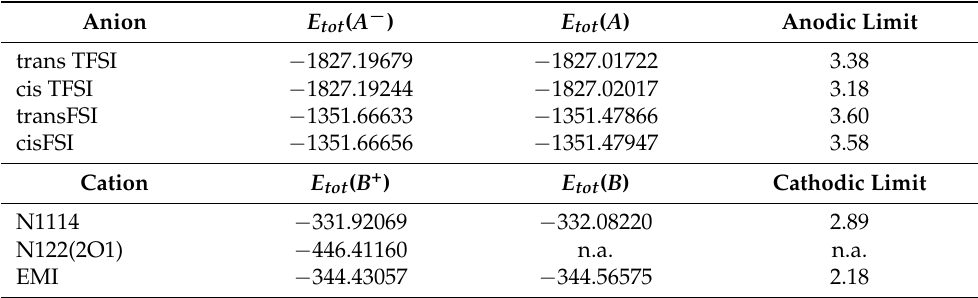
Table 6. Gibbs energy (in atomic units) of anions and cations and their relaxed neutral forms calculated at the B3LYP/6-31G** level of theory and derived anodic or cathodic limit (V). Anion E tot ( A − ) E tot ( A )